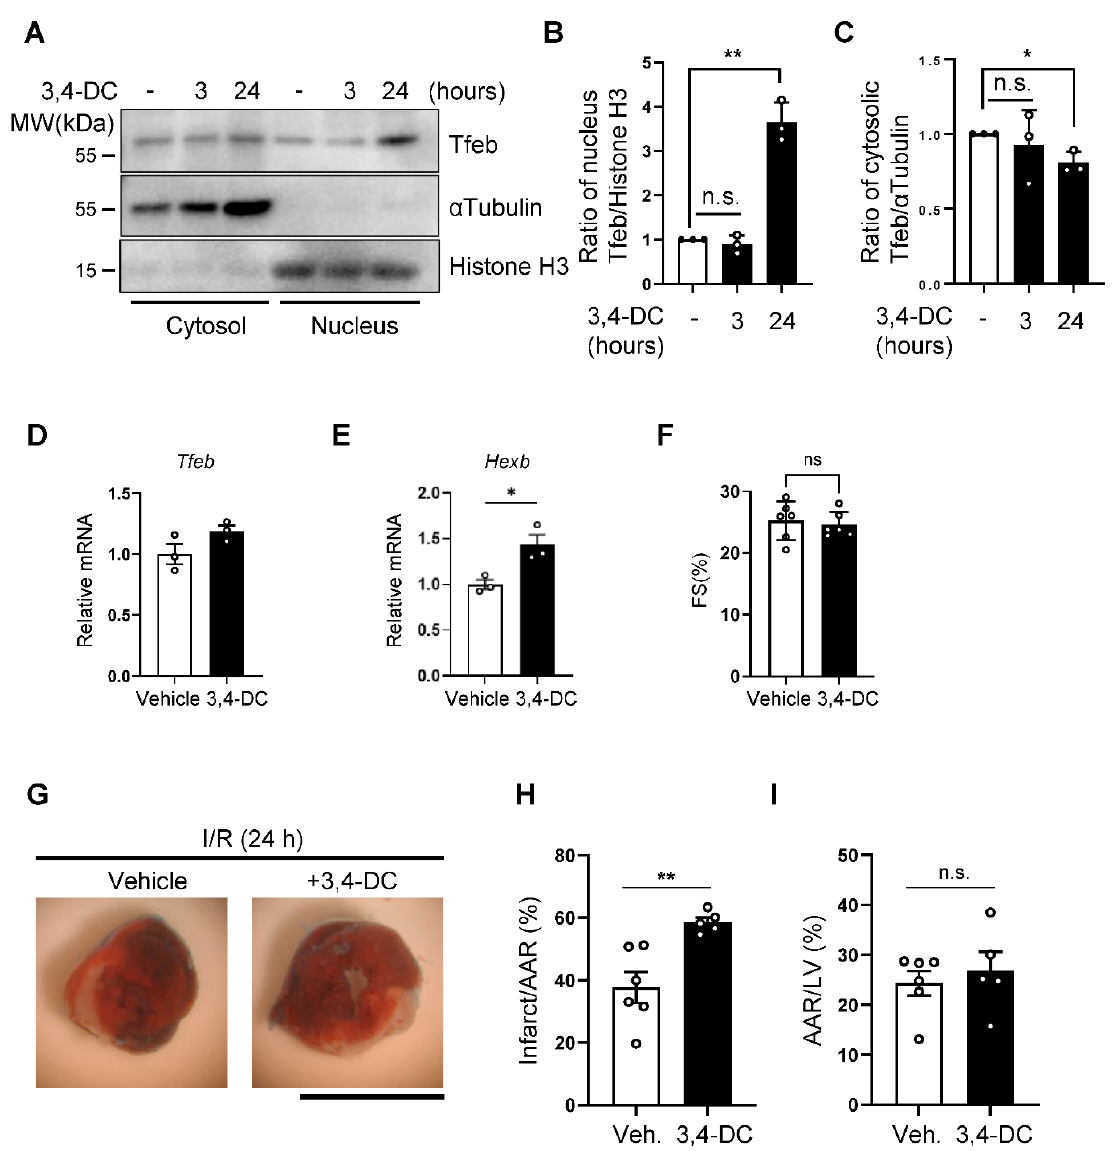
Figure 6. Activation of Tfeb by 3,4-dimethoxychalcone aggravates I/R injury. ( A – C ) NRCMs were treated with 30 µM 3,4-dimethoxychalcone (3,4-DC) for indicated time periods and subcellular frac- tions were analyzed via Western blotting using anti-Tfeb, anti- αTubulin and anti -Histone H3 anti- bodies ( A ). The ratio of Tfeb to Histone H3 in the nuclear fraction ( B ) and the ratio of Tfeb to α Tu- bulin in the cytosolic fraction ( C ) were quantified (mean values ± S.E., n = 3; ** p < 0.01). ( D , E ) 3,4- DC was dissolved in corn oil at a concentration of 230 mg/kg and injected intraperitoneally (150 μ L/mouse), and 3 h later, whole heart lysates were analyzed via qPCR analysis. Graphs showing relative gene expression levels of Tfeb ( C ) and Hexb ( D ). Mean ± S.E., n = 3; * p < 0.05. ( F ) Cardiac function in 3,4-DC- or vehicle-injected mice was evaluated with echocardiographic analyses. Frac- tional shorting (FS, %), an index of systolic function, is shown (mean ± S.E., n = 6). ( G – I ) 3,4-DC was dissolved in corn oil at a concentration of 230 mg/kg and injected intraperitoneally (150 μL/ mouse) immediately after reperfusion. Representative images of LV myocardial sections after Alcian blue and triphenyltetrazolium chloride (TTC) staining (scale bar = 1 mm) ( G ). The ratios of the infarction area to area at risk (AAR) ( H ) and AAR to total LV ( I ) are shown (mean value ±S.E., n = 6 (corn oil); n = 5 (3,4-DC); ** p < 0.01).